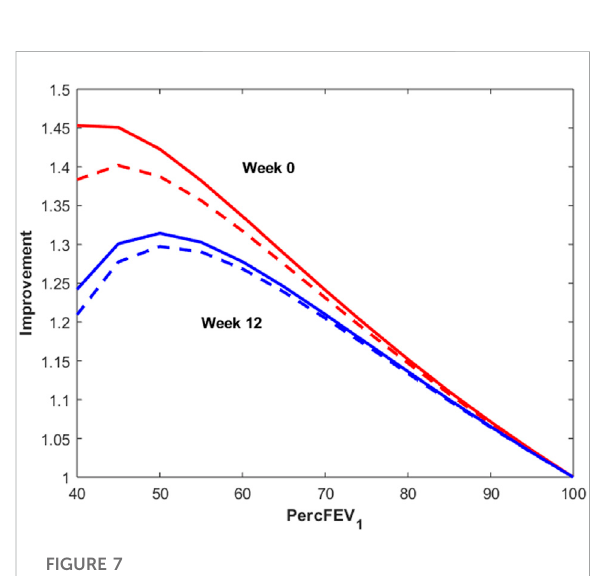
FIGURE 7 Improvement index as a function of percentage of predicted FEV 1 for a male subject, 175 cm height, aged 30 years, undergoing 12 μ g (dotted lines) or 24 μ g (continuous lines) of inhaled formoterol at week 0 (red lines) and week 12 (blue